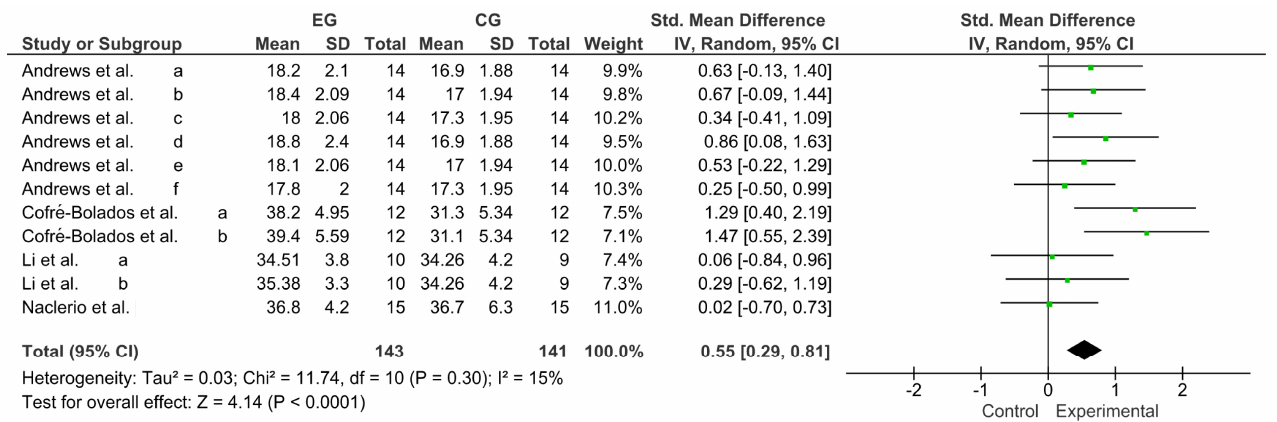
Figure 6. Forest plot comparing the effects of training with VR on time in sprint tests [31,35,46,49].